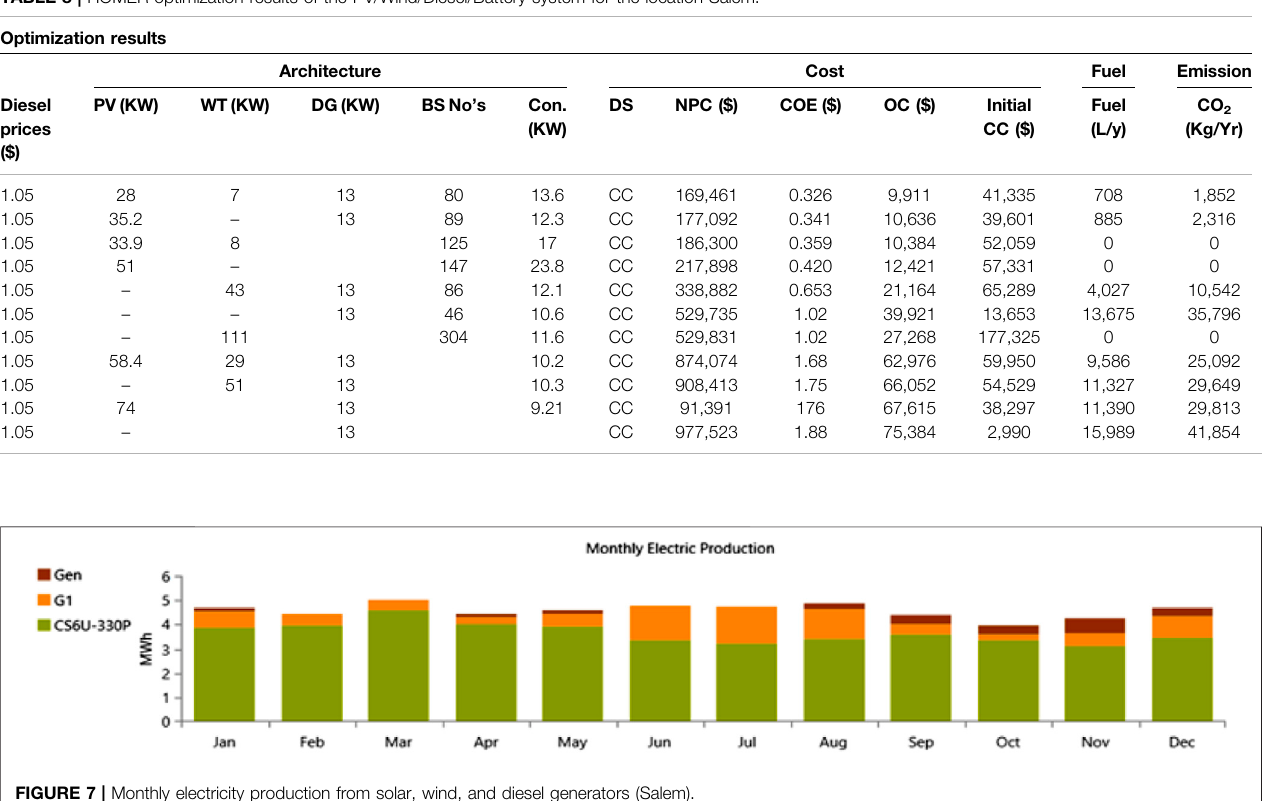
FIGURE 7 | Monthly electricity production from solar, wind, and diesel generators (Salem).